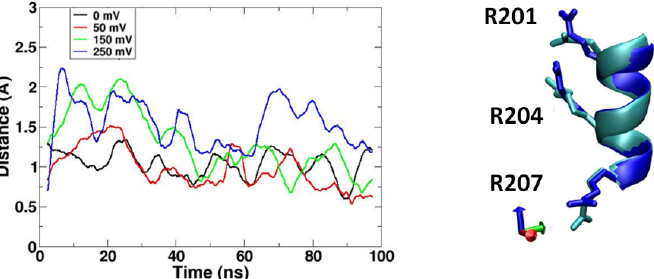
Figure 4. ( Left ) The moving distance of the side chains of three arginine residues on the S4 helix along the normal to the membrane bilayers. ( Right ) Superposition of the S4 helix (ribbon representation with the backbone of residues 201 to 207) between a closed conformation (cyan, simulation with 0 mV) and an open conformation from simulation 4 (blue, 250 mV).